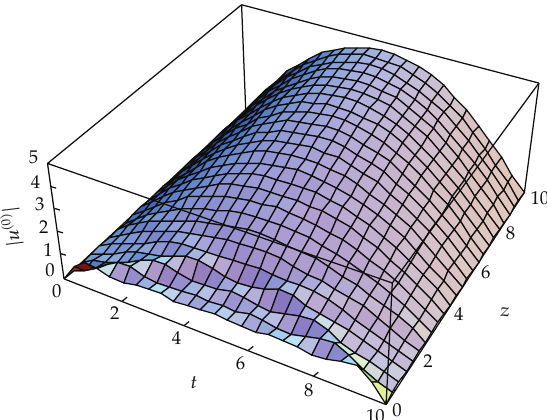
Figure 13: The zero-order approximation of | u (cid:3) 0 (cid:4) | at α (cid:8) 1, T (cid:8) 10, γ (cid:8) 02 with considering only one term in the series (cid:3) M (cid:8) 1 (cid:4) .